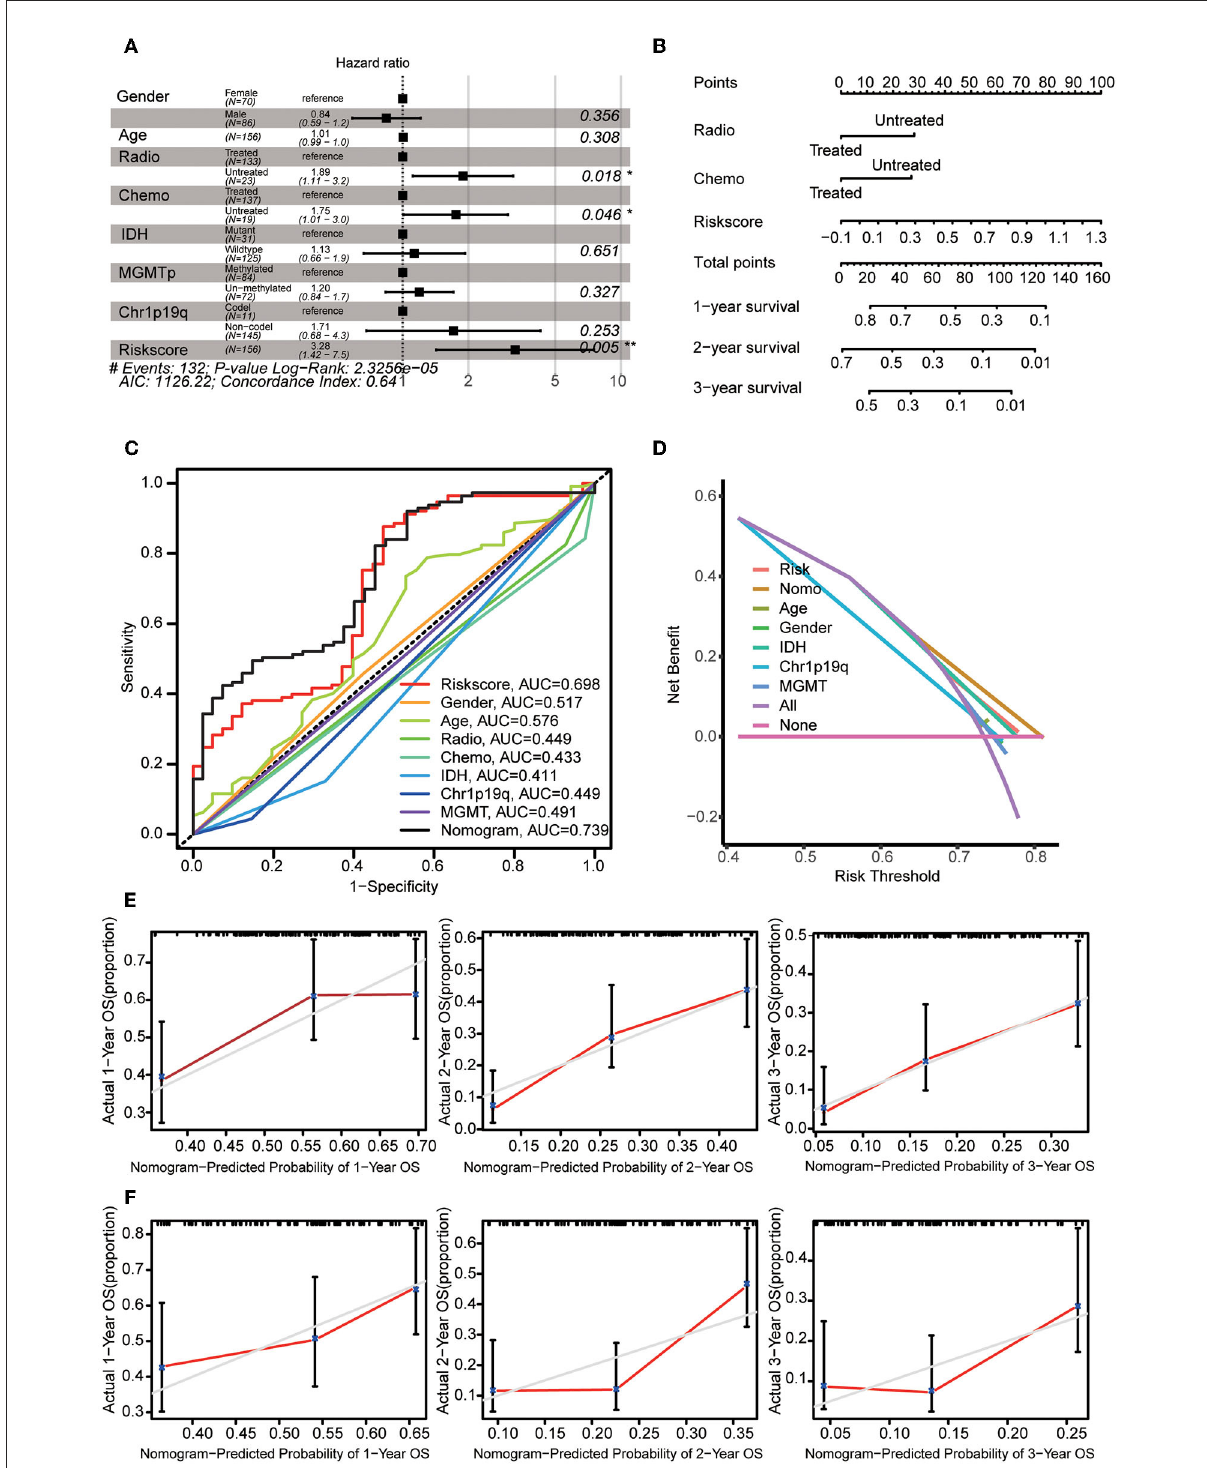
FIGURE6 Construction of the nomogram. (A) Multivariate Cox regression analysis was adopted to select the independent variables, including radiotherapy status, chemotherapy status, and risk score. (B) The nomogram constructed using radiotherapy status, chemotherapy status and risk score. For each patient, three lines are drawn upwards to verify the points assigned from the three predictors of the nomogram. The sum of these points is located on the ‘Total Points’ axis. Then, a line is drawn downwards to assess the 1–3-year overall survival probabilities of patients with GBM. (C) Multivariate ROC analysis was used to compare the predictive power of each variable. (D) DCA was used to compare the predictive power of each variable. (E) The calibration curve for the evaluation of the nomogram. The Y-axis shows the actual survival rate, while the X-axis shows the nomogram-estimated 1–3-year OS probabilities of patients in the training set. (F) The predicted 1–3-year OS probabilities of patients in the verification